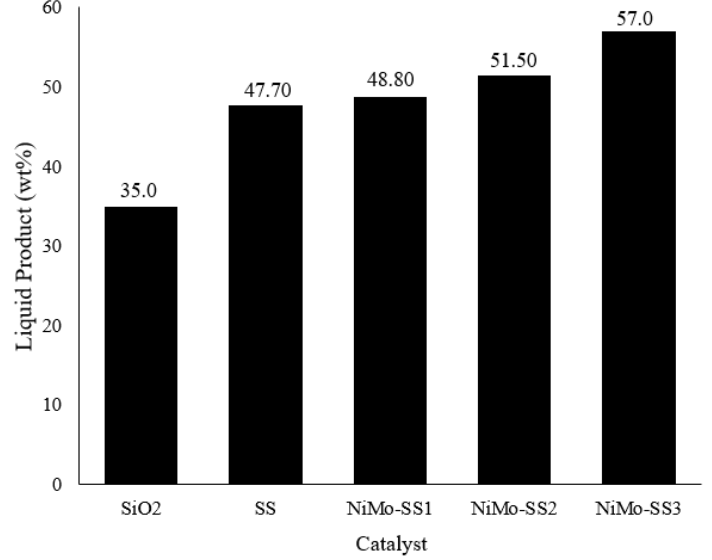
Figure 8. Percentage of the liquid product from the catalytic hydrocracking of fresh frying oil at 450 °C with different catalysts. Table 5. Catalyst selectivity test from the catalytic hydrocracking of fresh frying oil.